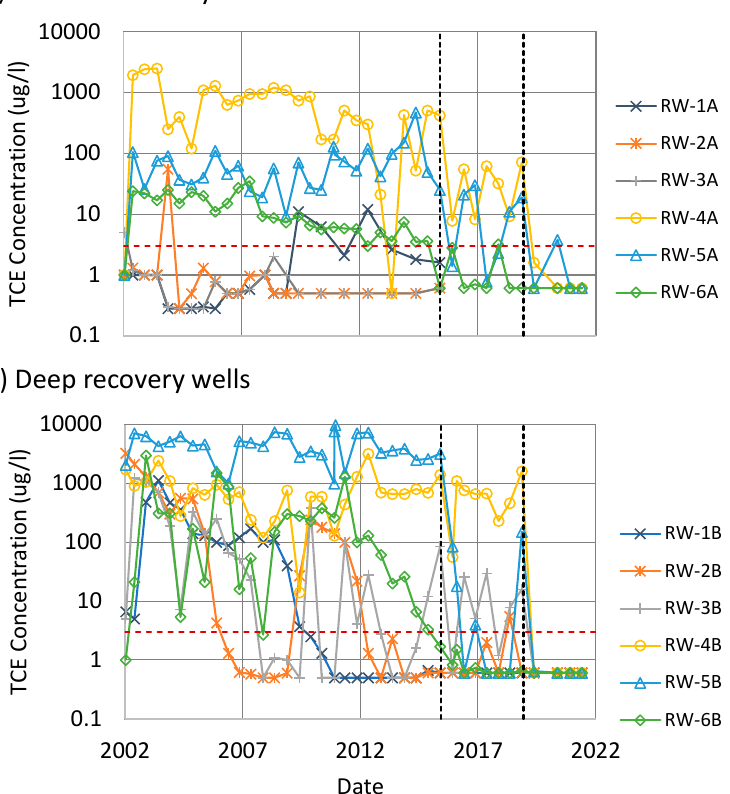
Figure 3. Concentration–time series for TCE from ( a ) shallow and ( b ) deep recovery wells used to hydraulically isolate the primary source zone. The vertical dashed lines indicate the first biotreatment injection in 2015 and second biotreatment injection in 2019. The red horizontal dashed line indicates the TCE remediation goal. Data shown in the graphs were taken from Geosyntec [63].